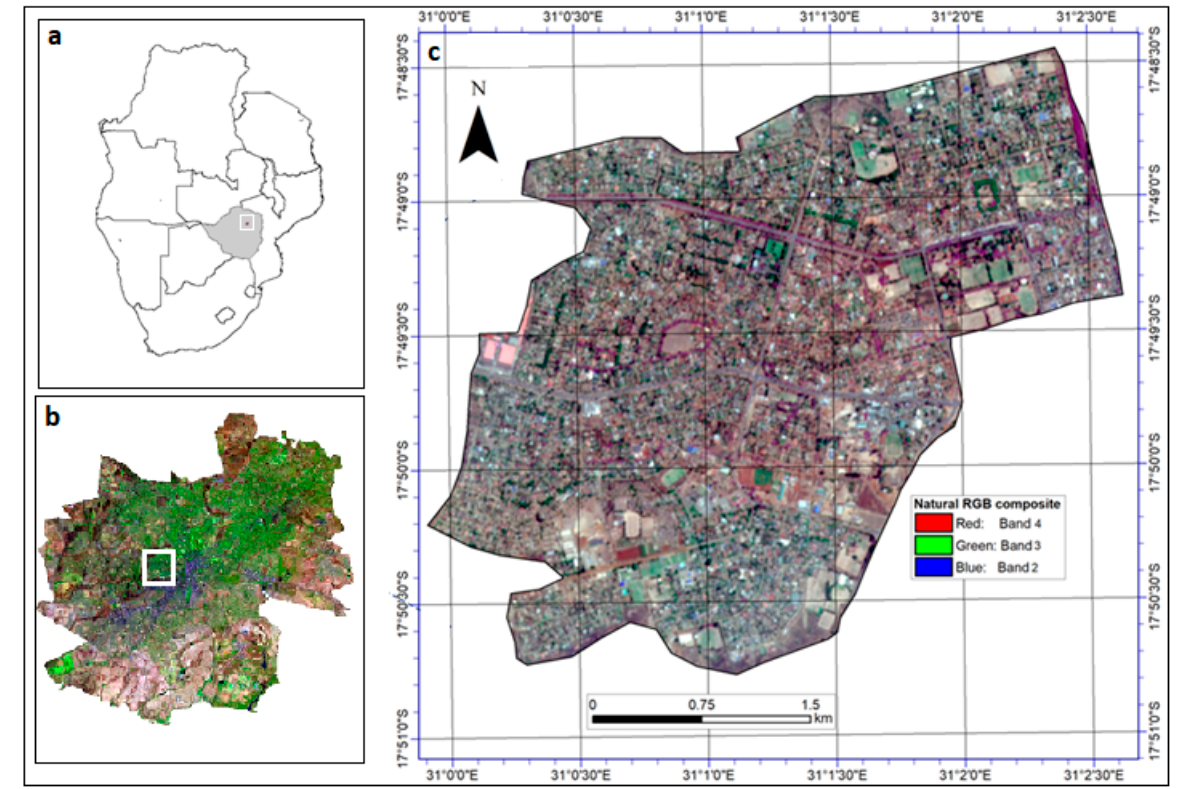
Figure 1. Location of the study area in Southern Africa, Zimbabwe and Harare ( a ), Harare and the study area ( b ) and 10-m resolution natural colour composite showing variations of LULC in the study area ( c ).